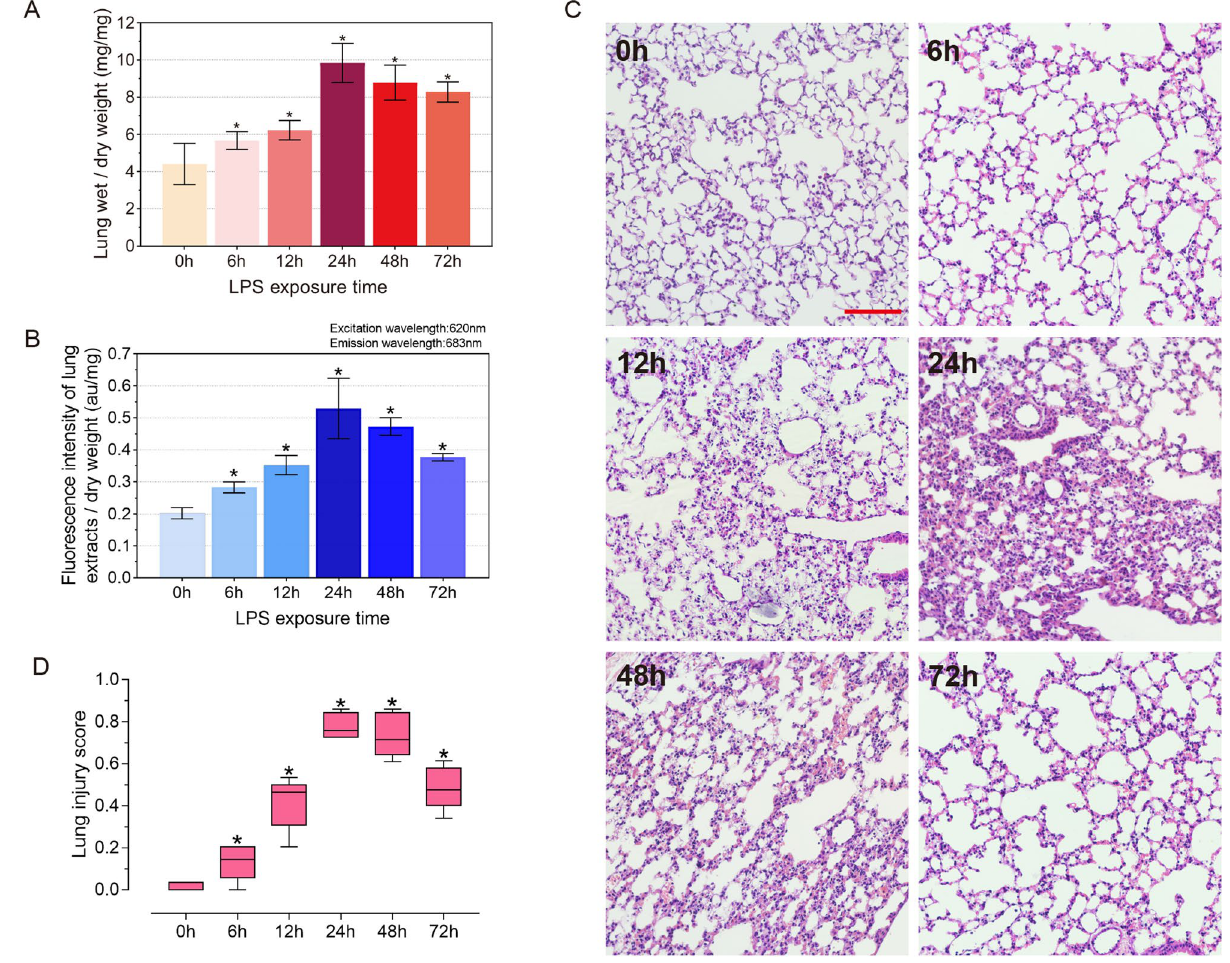
Figure 1. Dynamic time pulmonary function indexes and inflammatory response in ALI mice. ( A ) Wet/dry weight ratio of lungs in mice after LPS treatment at 0, 6, 12, 24, 48 and 72 h (n = 5–10). ( B ) Evans blue assay for lung vascular endothelial permeability in LPS-treated mice at 0, 6, 12, 24, 48 and 72 h (n = 6). ( C ) HE staining of mice lung tissues at 0, 6, 12, 24, 48 and 72 h after LPS treatment (×200 magnification, scale bar: 100 μm for all images). ( D ) Lung injury score at 0–72 h (n = 5). Data are presented as the mean ± SEM. *P < 0.05 vs. the control